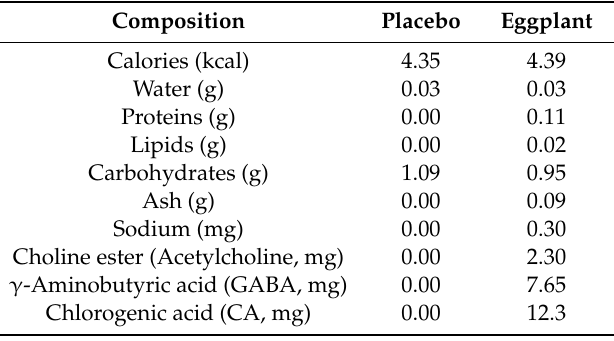
Table 2. Nutrient composition of the eggplant and placebo capsules administered per